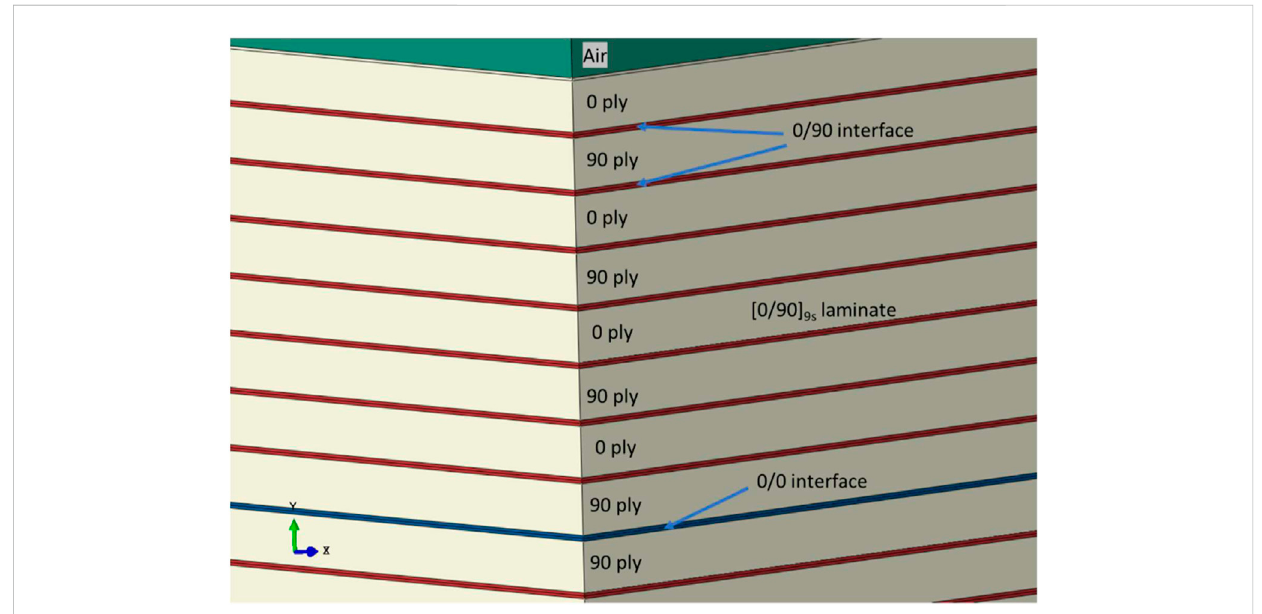
FIGURE 11 Modelling of plies and interfaces for a [0/90] 9s laminate. Each interface layer consists of a part of the top ply and a part of the bottom ply.